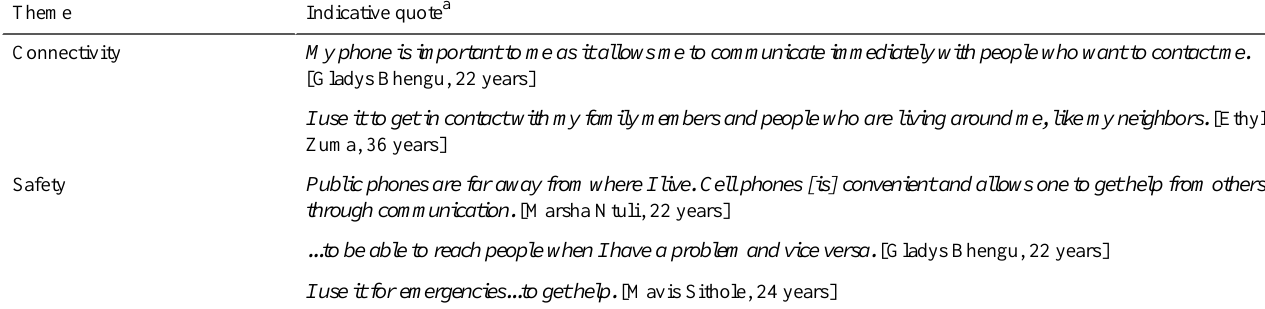
Table 2. Themes emerging from the analysis of the focus group session held with 12 mothers living with HIV (participant group 2). Indicative quote a